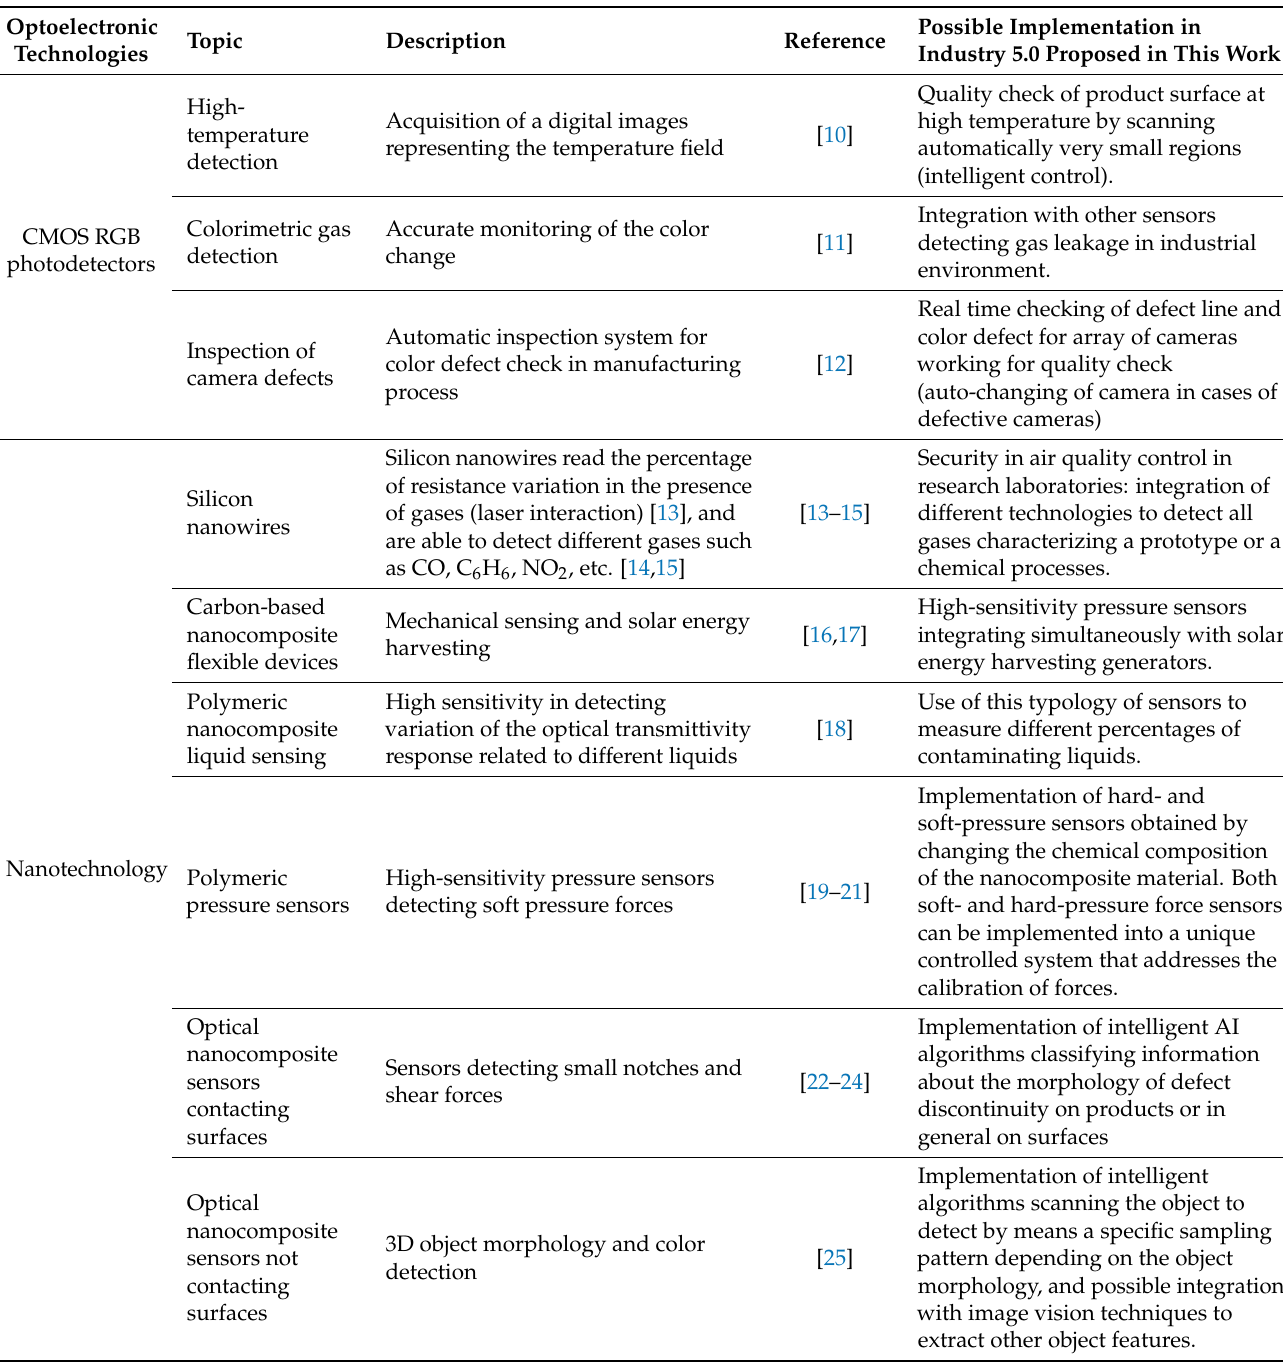
Table 1. State of the art: some advanced optoelectronic sensors adaptable for industrial applications in Industry 5.0